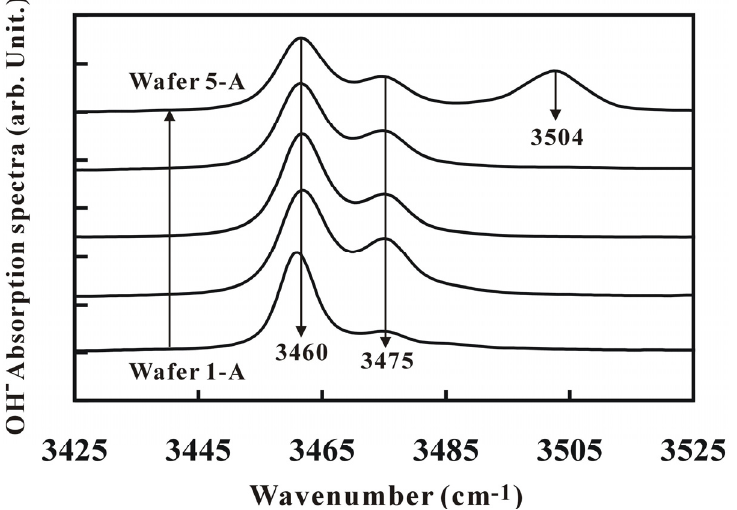
Figure 4. Infrared absorption spectra of the as grown